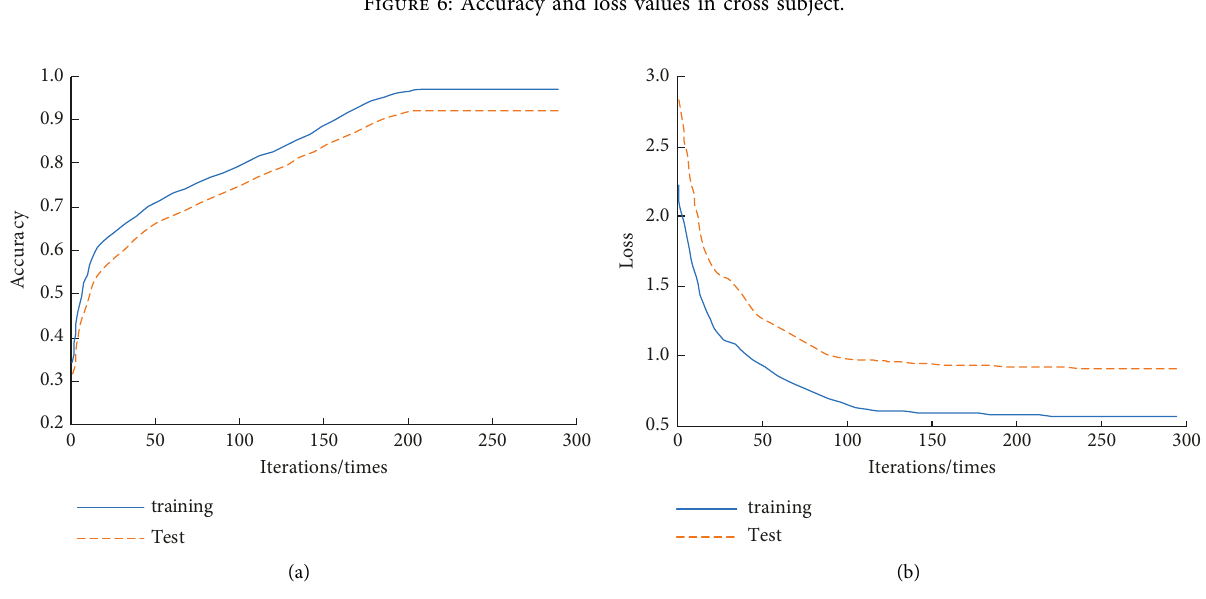
Figure 6: Accuracy and loss values in cross subject.